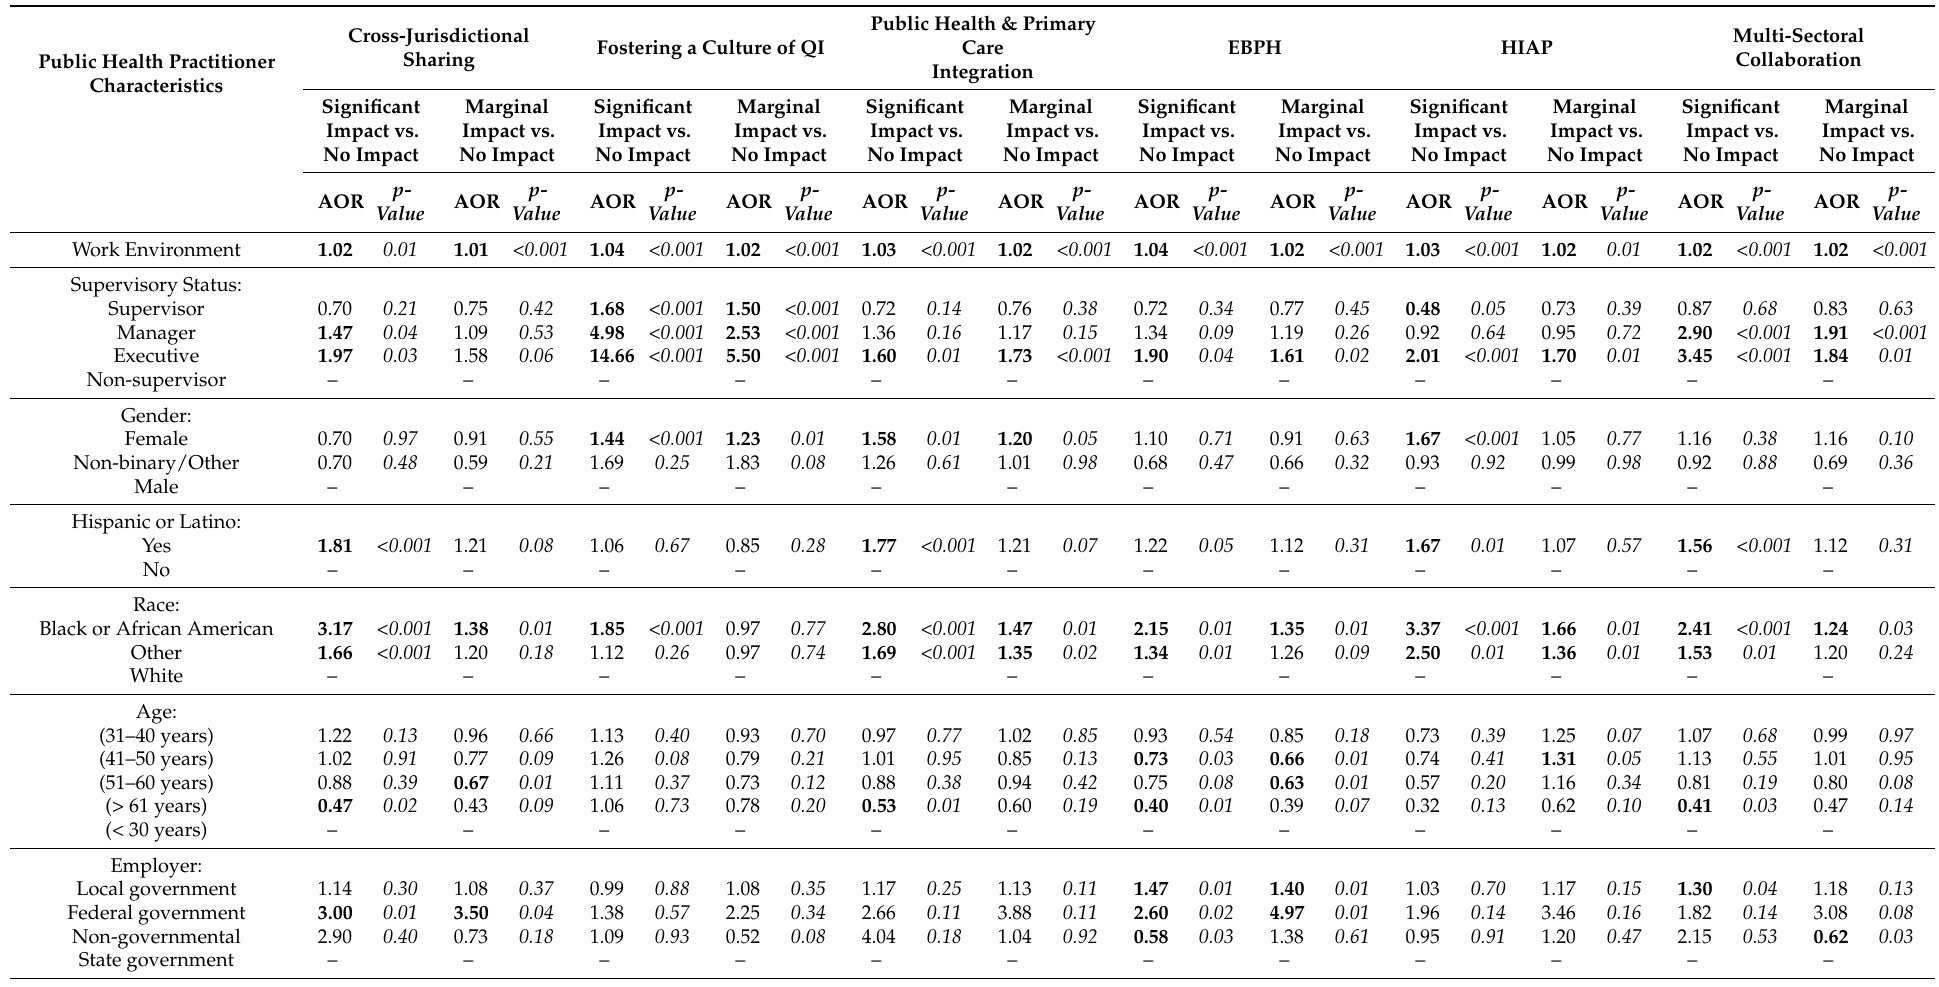
Table 2. Multinomial logistic regression of the perceived impact of the emerging public health trends on the day-to-day work of state and local public health workforce.